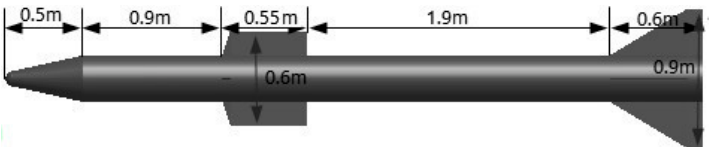
Figure 7. Missile structural model and its size.